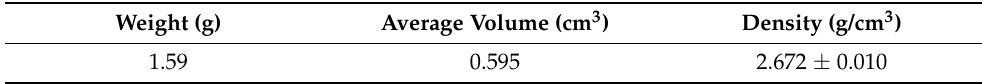
Table 2. Average density of the bioactive glass calcined at 600 ◦ C.